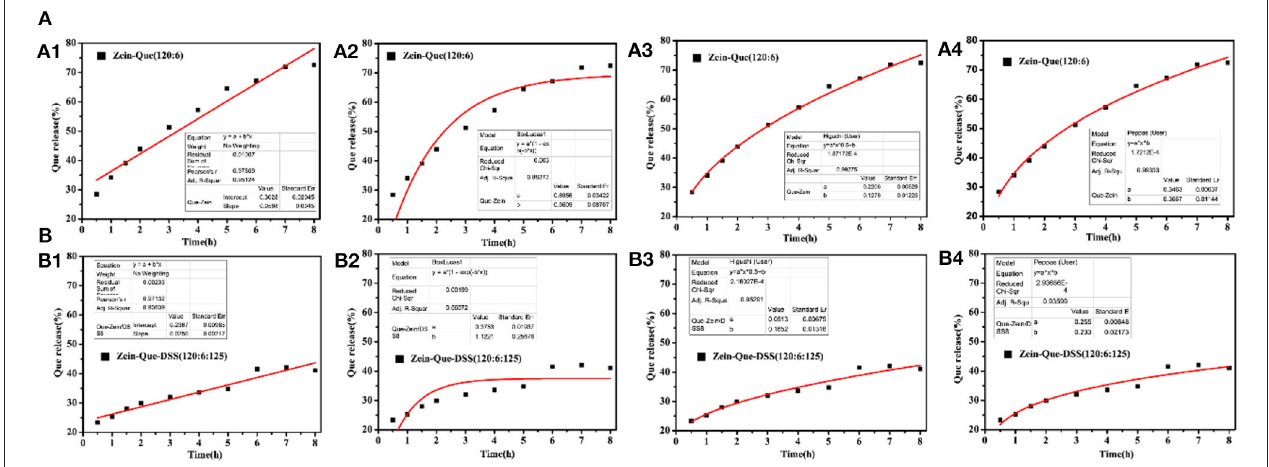
FIGURE 7 | Que release fitting curve of the obtained nanoparticles and (A) Zein-Que (120:6) nanoparticles, (B) Zein-Que-DSS (120:6:125) complex nanoparticles; 1: Zero-order, 2: First-order, 3: Higuchi model, 4: Ritger-Peppas model.